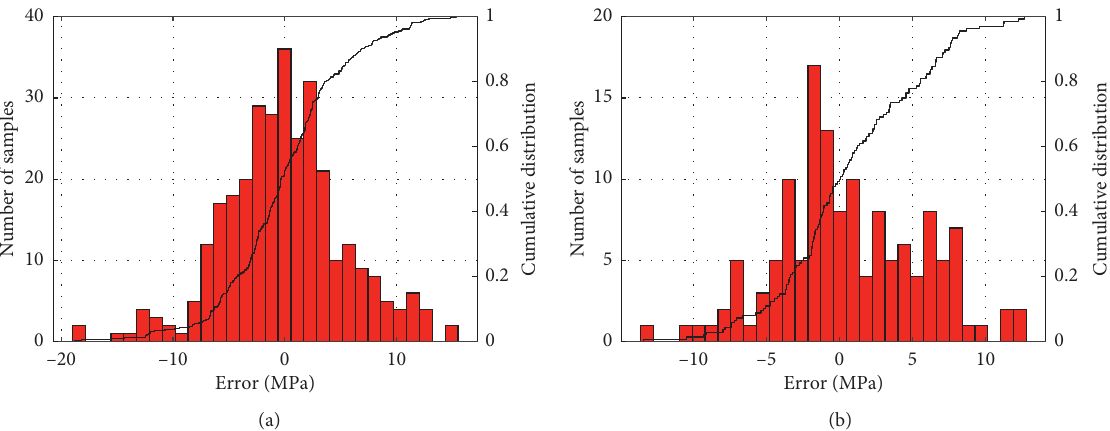
Figure 8: Error between target and output value plots for the case of the best RF architecture: (a) training dataset and (b) testing dataset.